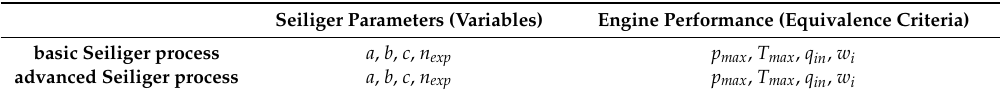
Table 4. Variables and equivalence criteria in combustion fit functions.